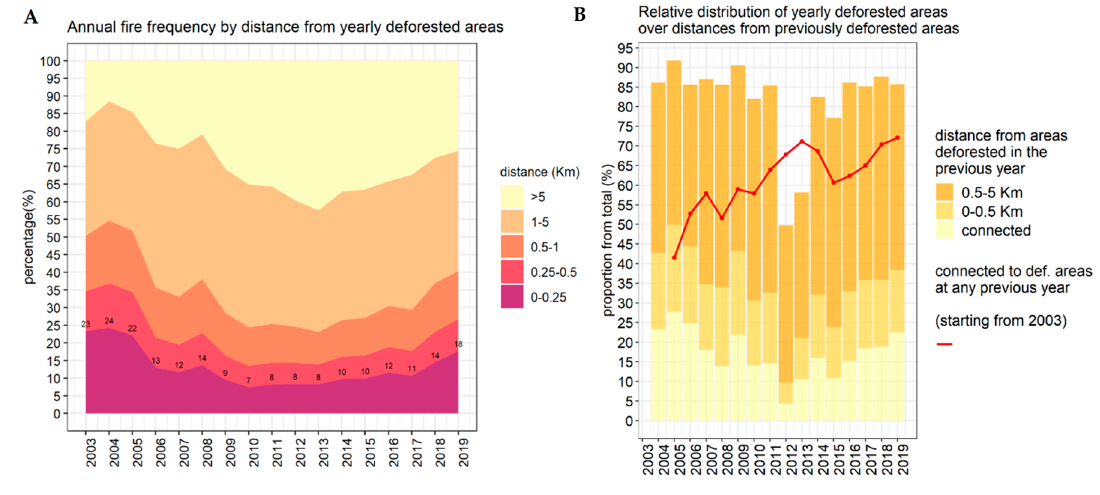
Figure 8. ( A ) The proportion of total active fires in a given year within five distance intervals from deforested areas in that same year. ( B ) The proportion of total deforestation polygons in a given year, within specified distances from deforestation polygons in the respective previous year, or connected to deforestation polygons at any previous year, from 2003.